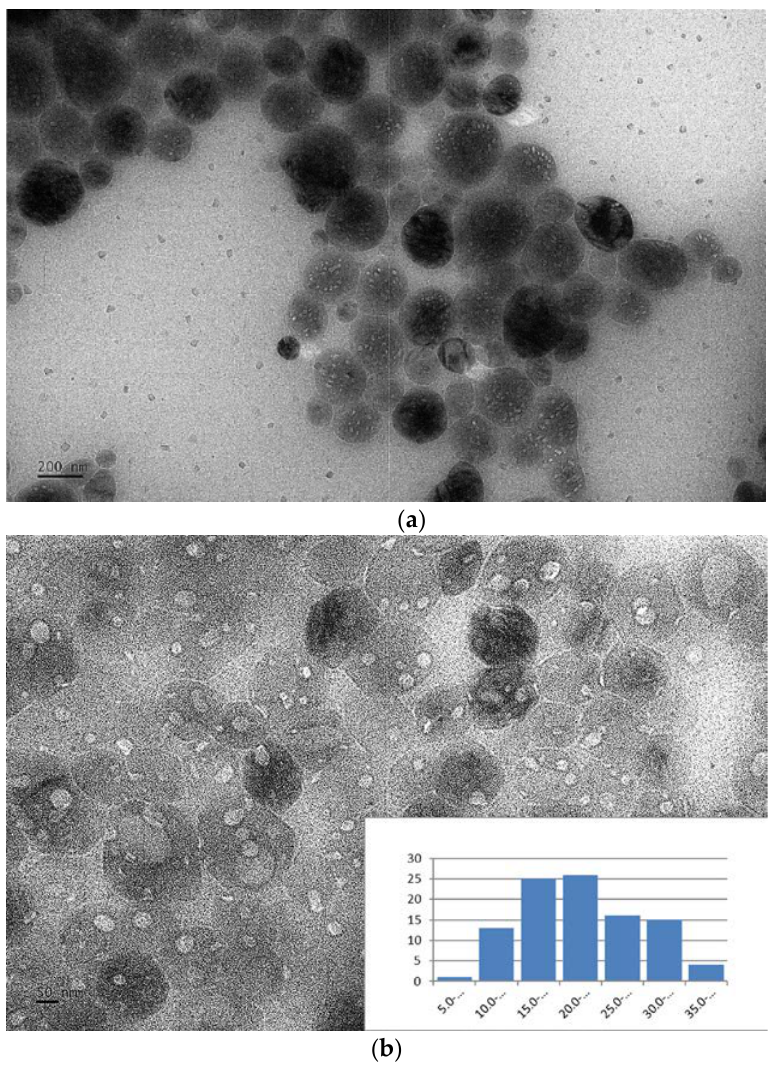
Figure 6. TEM image of O-CDs embedded in SPA. ( a , b ) are in different scale. The inset in ( b ) is the size histogram of O-CDs embedded in SPA.